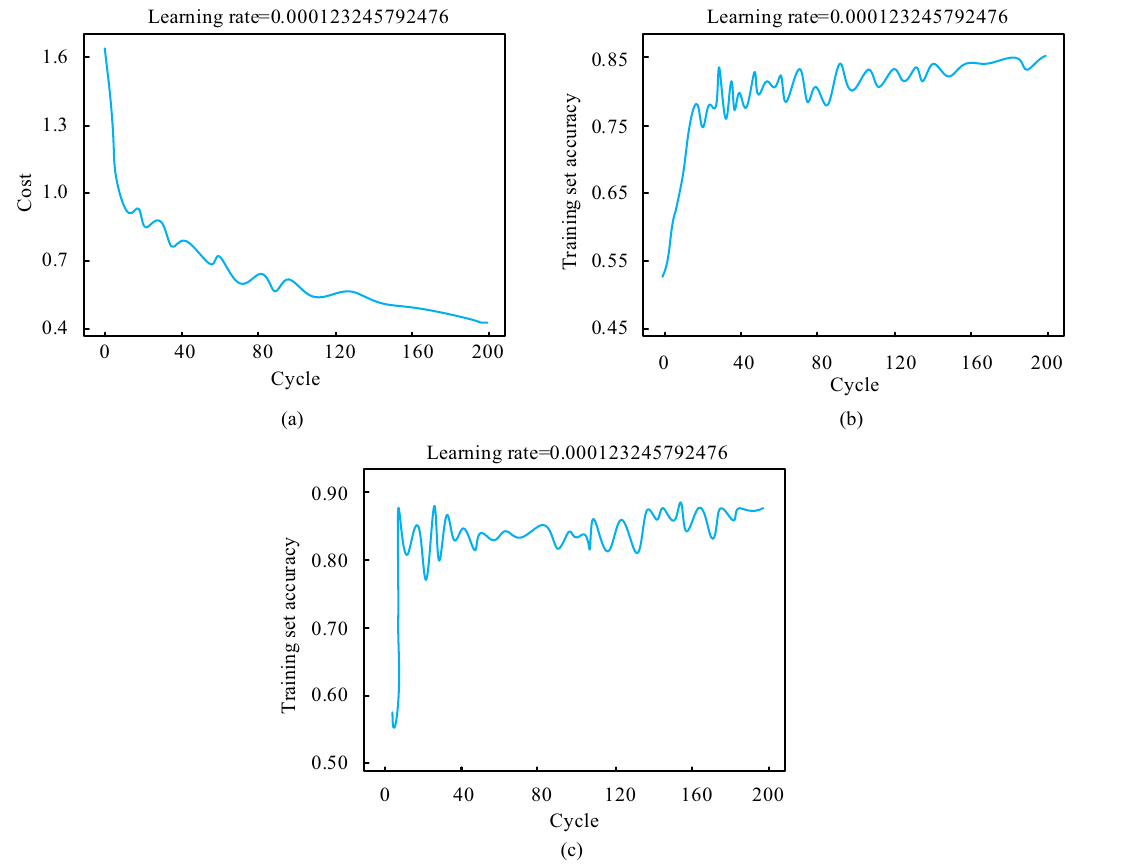
Figure 7: Cost and accuracy of encrypted datasets ( co - encryption ) : ( a ) cost, ( b ) training set accuracy, and ( c ) validation set